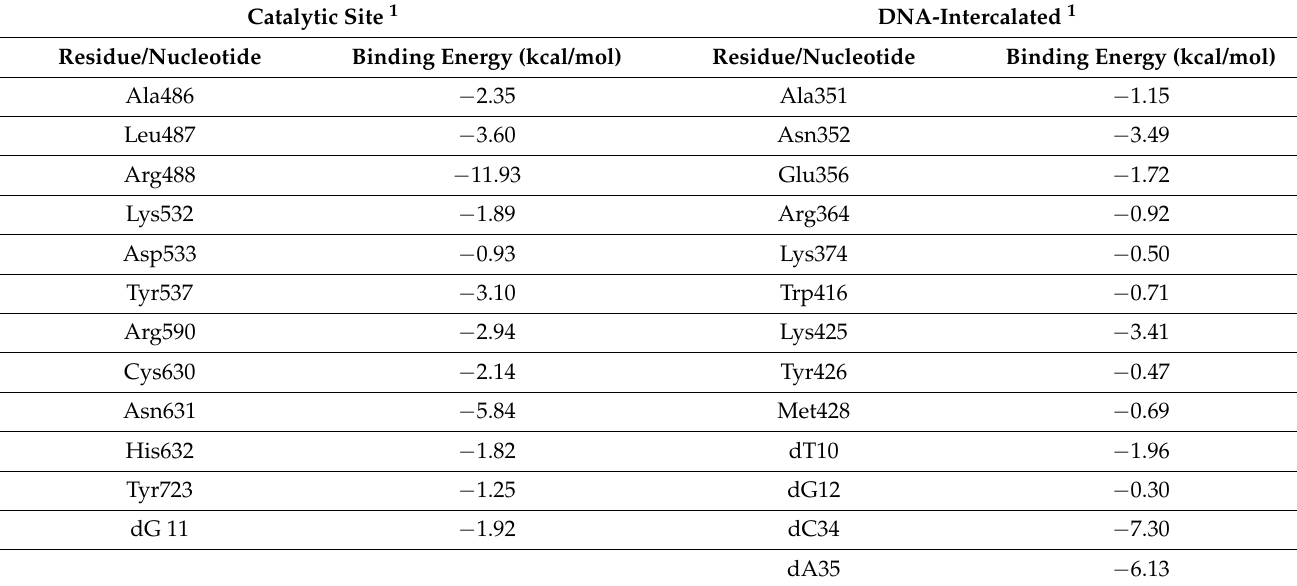
Table 2. This MM/GBSA per-nucleotide/residue decomposition